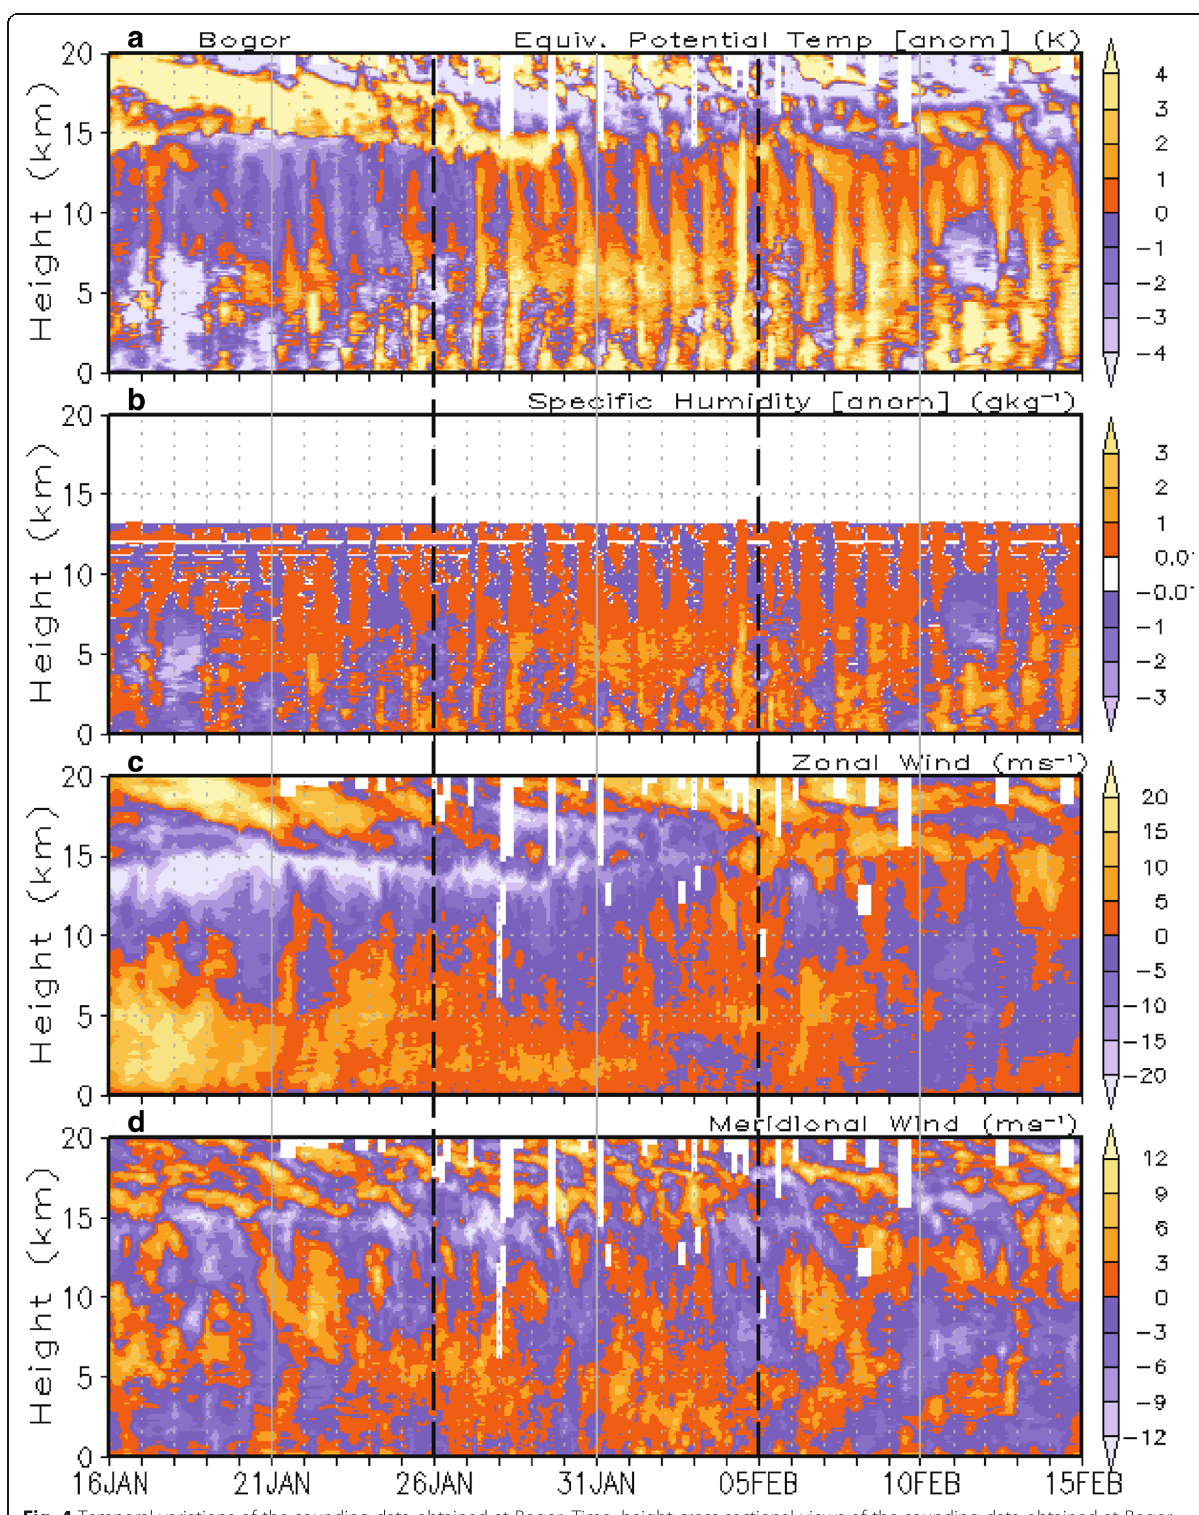
Fig. 4 Temporal variations of the sounding data obtained at Bogor. Time – height cross-sectional views of the sounding data obtained at Bogor during the campaign period. a Equivalent potential temperature (anomaly), b specific humidity (anomaly), and c zonal and d meridional wind speeds. Anomalies were calculated from the period averaged data of Bogor at each